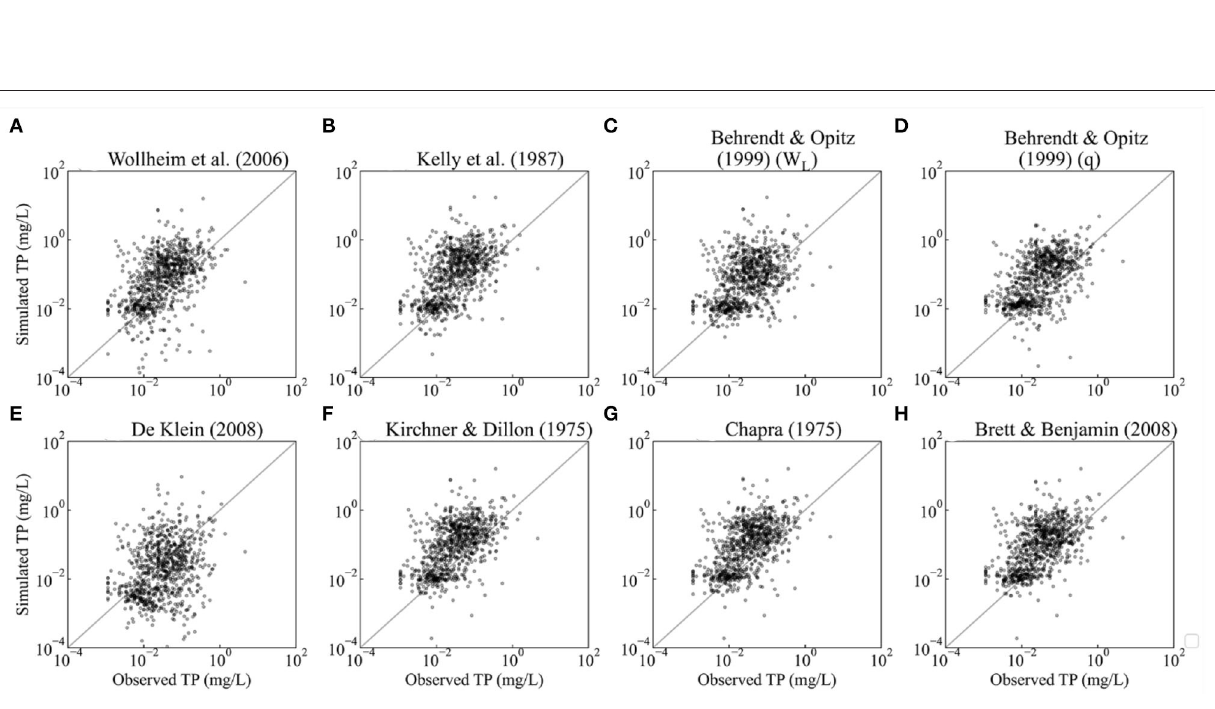
FIGURE 3 | Validation of predicted values against observations of annual average concentration for riverine P (each dot represents the predicted values against average observed P concentration of the measurement stations within the same cell). The sample size is 849, the number of grid cells covered by measurement stations. (A–H) indicate the plots of different retention